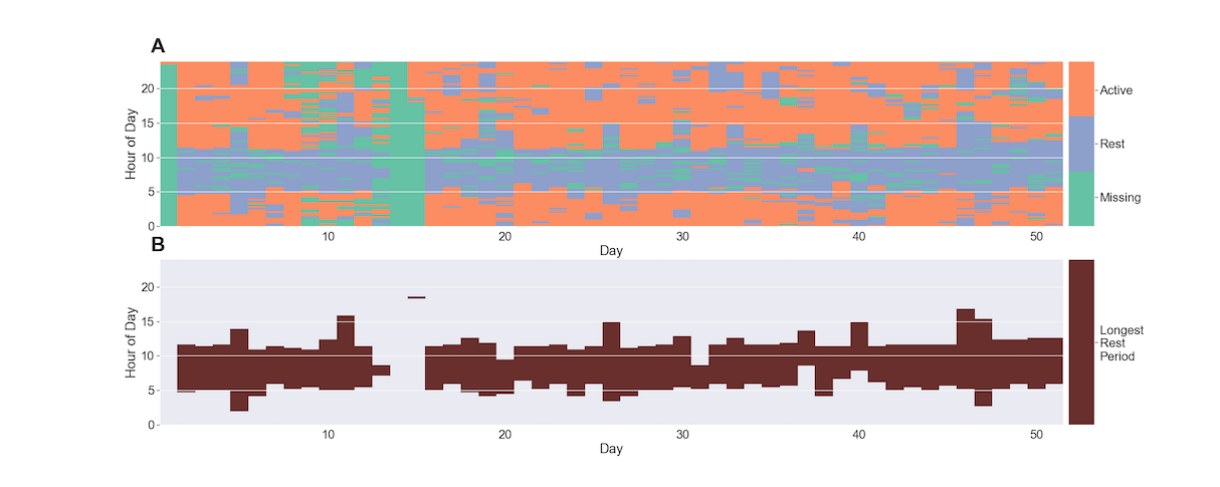
Figure 3. Rest state interval designations and longest rest periods for a single subject. (A) All 15-minute windows were classified as either rest, active, or missing, according to the procedure discussed in the Methods section. (B) The longest rest period for each day was identified using the procedure shown in Figure